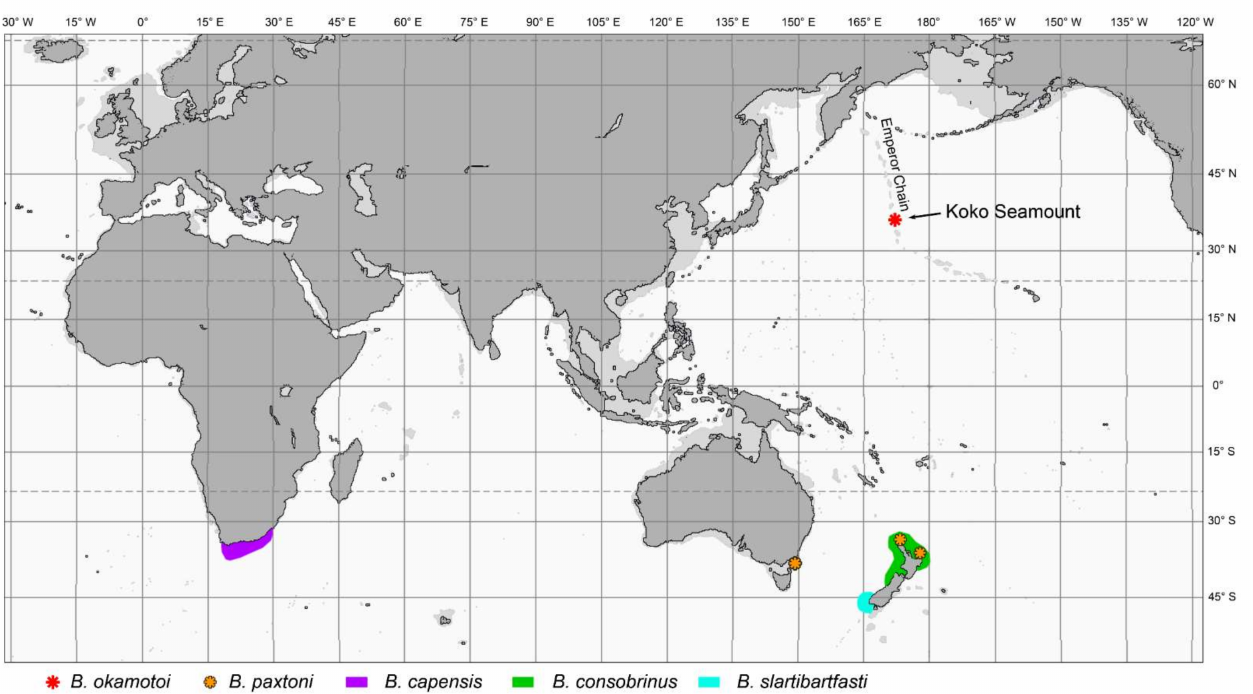
Figure 4. Geographic distributions of extant Bidenichthys